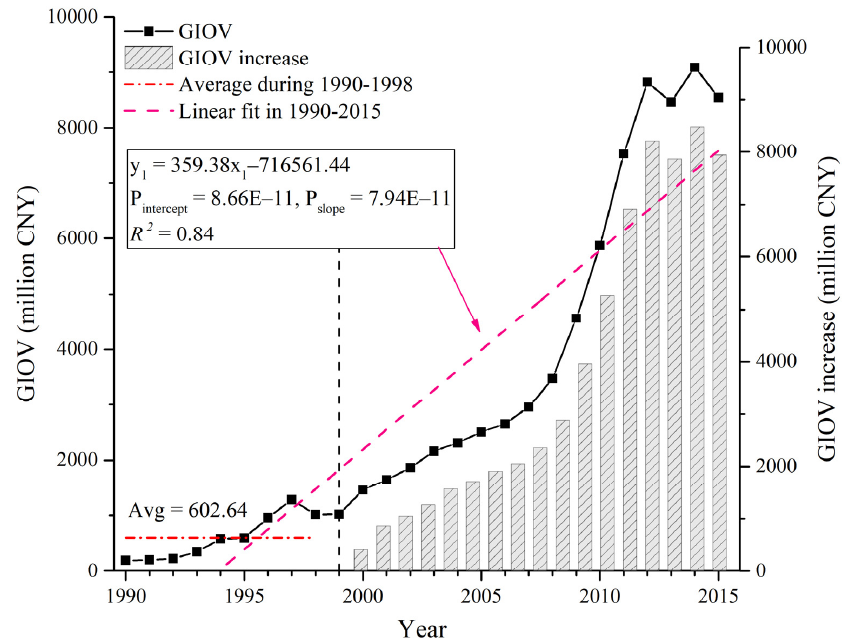
Figure 11. Gross industrial output value (GIOV) of the three towns in the HN basin.